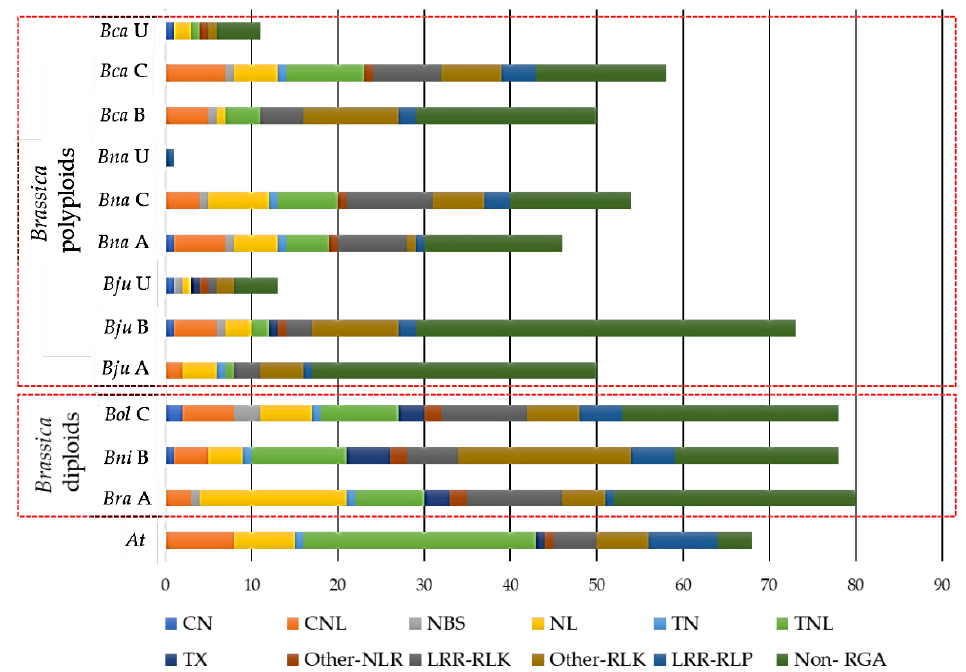
Figure 1. Distribution of cloned disease resistance gene homologs (CDRHs) with their resistance gene analogs (RGA) classes/subclasses (CN = coiled-coil (CC)-nucleotide-binding site (NBS), CNL = CC-NBS-leucine rice repeats (LRR), NL = NBS-LRR, TN = Toll/Interleukin-1 receptor (TIR)-LRR, TNL = Toll/Interleukin-1 receptor (TIR)-NBS-LRR, TX = Toll/Interleukin-1 receptor (TIR) with other domains, Other-NLR= NBS-LRR with other domains, LRR-RLK= LRR-receptor-like kinase proteins (RLK), Other-RLK = RLK with other domains, LRR-RLP = LRR-receptor-like proteins) and Non-RGA (CDRHs identified without RGA domain based on the RGAugury pipeline) in Brassica rapa (Bra), B. nigra (Bni), B. oleracea (Bol), B. juncea (Bju), B. napus (Bna), B. carinata (Bca), and Arabidopsis thaliana (At ). A, B, C, and U (unplaced) refer to the genome/sub-genome of Brassica species.